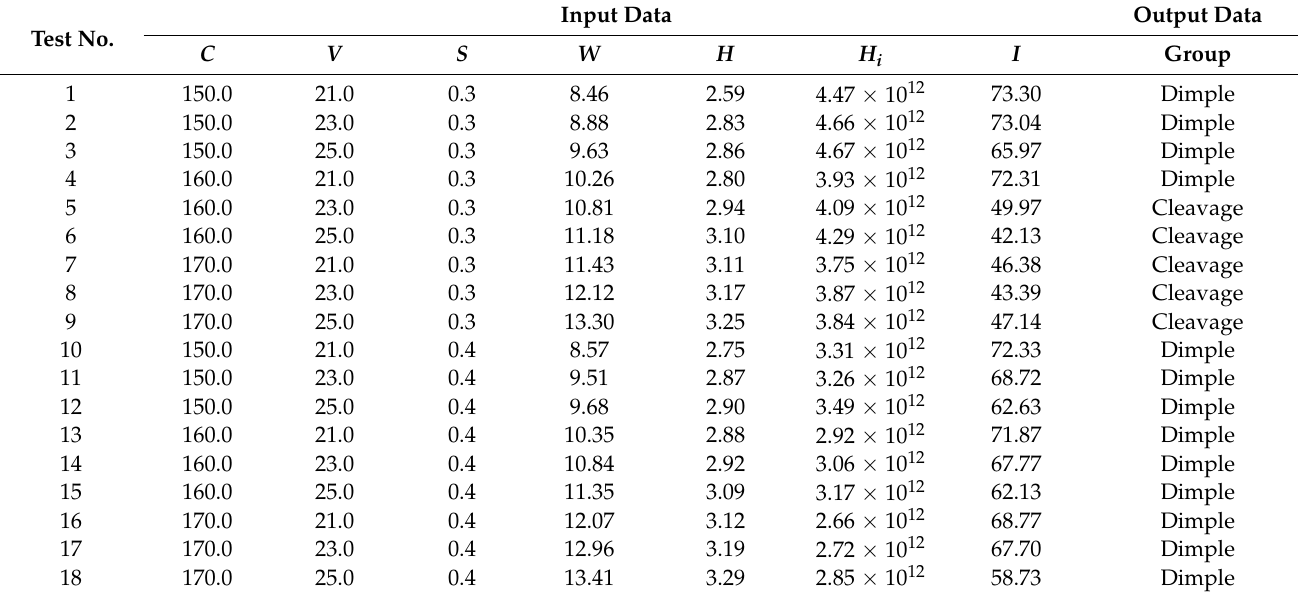
Table 10. Learning data for discriminant of welding quality.